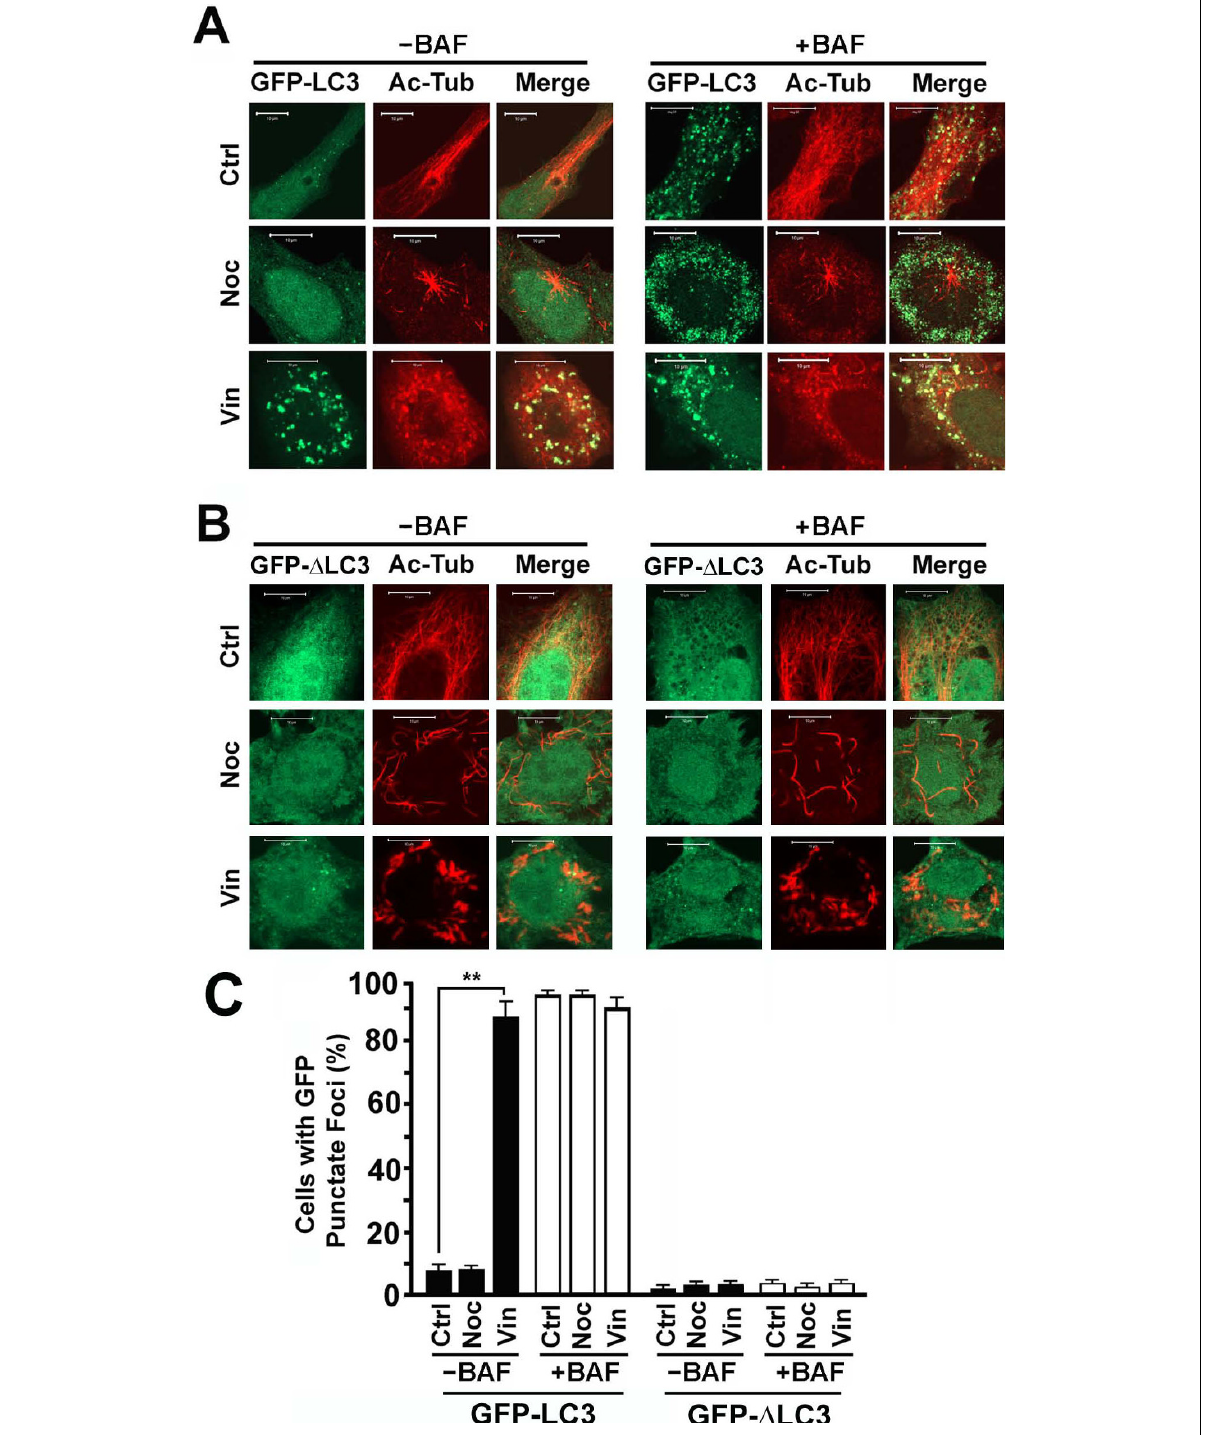
Figure 4 Vinblastine-induced depolymerization of acetylated microtubules is coincident with accumulation of GFP-LC3 punctate foci . ( A, B ) Accumulation of GFP punctate foci in HeLa cells stably expressing GFP-LC3 ( A ) or GFP- Δ LC3 ( B ) untreated or treated with either nocodazole or vinblastine in the absence or presence of lysosomal inhibitor bafilomycin A1 (BAF) overnight. The acetylated microtubules are counterstained with anti-acetylated a -tubulin antibody. ( C ) Percentage of GFP expressing cells with more than 10 GFP punctate foci. Only GFP punctate foci occupying an area with diameter greater than four pixels (~0.15 μ m) were counted. The data is the average and standard deviation of three independent experiments. **, p < 0.01 as calculated by Student ’ s